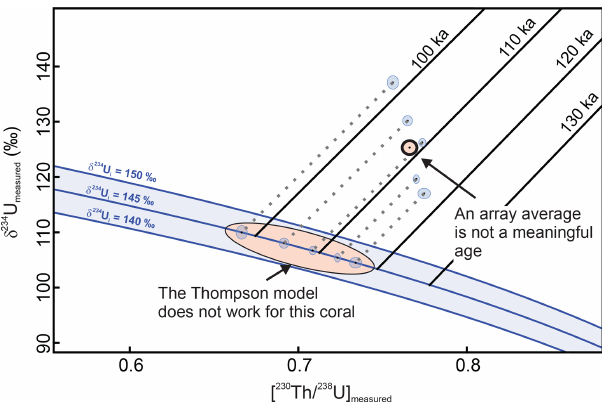
Figure 4. Open-system model of Thompson et al. (2003) applied to U-series measurements from Seychelles sample DU15-010 from Fig. 3a (Dutton et al., 2015b). In this case, the diagenetic array is roughly perpendicular to the open-system isochrons, so the open- system correction does not change the high degree of age variability within this coral colony ( ∼ 20kyr in total). For this same reason, an array average does not yield a meaningful